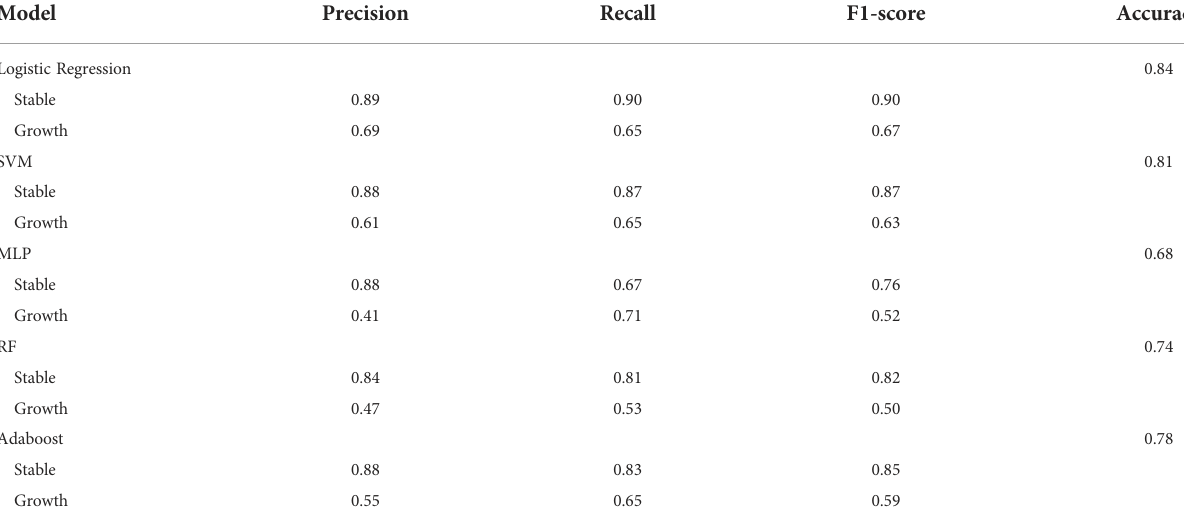
TABLE 2 The classi fi cation report of the different models on the validation